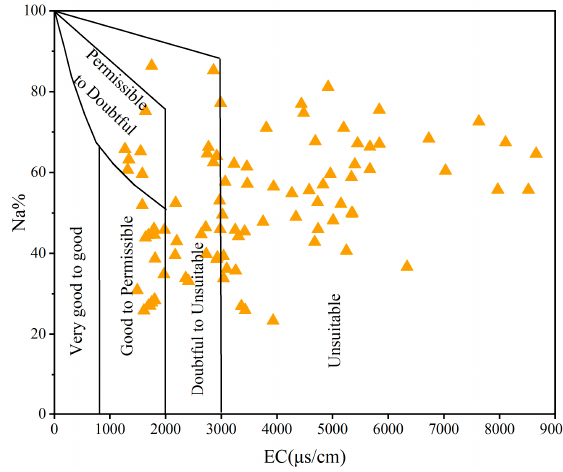
Figure 11. Suitability of groundwater irrigation based on Na%.